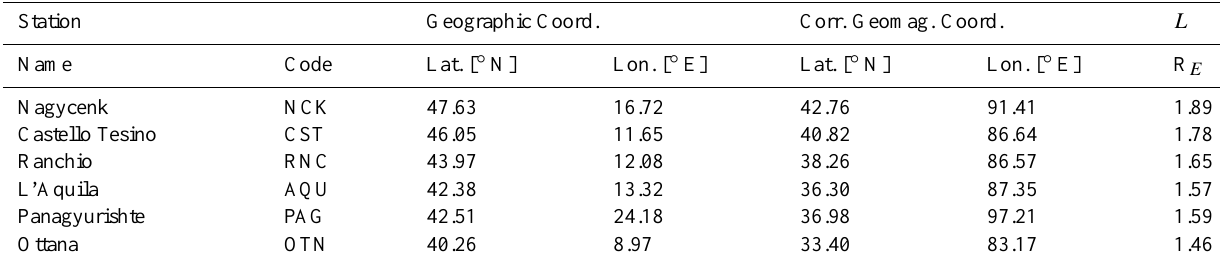
Table 1. Coordinates of the ULF magnetic stations. Station Geographic